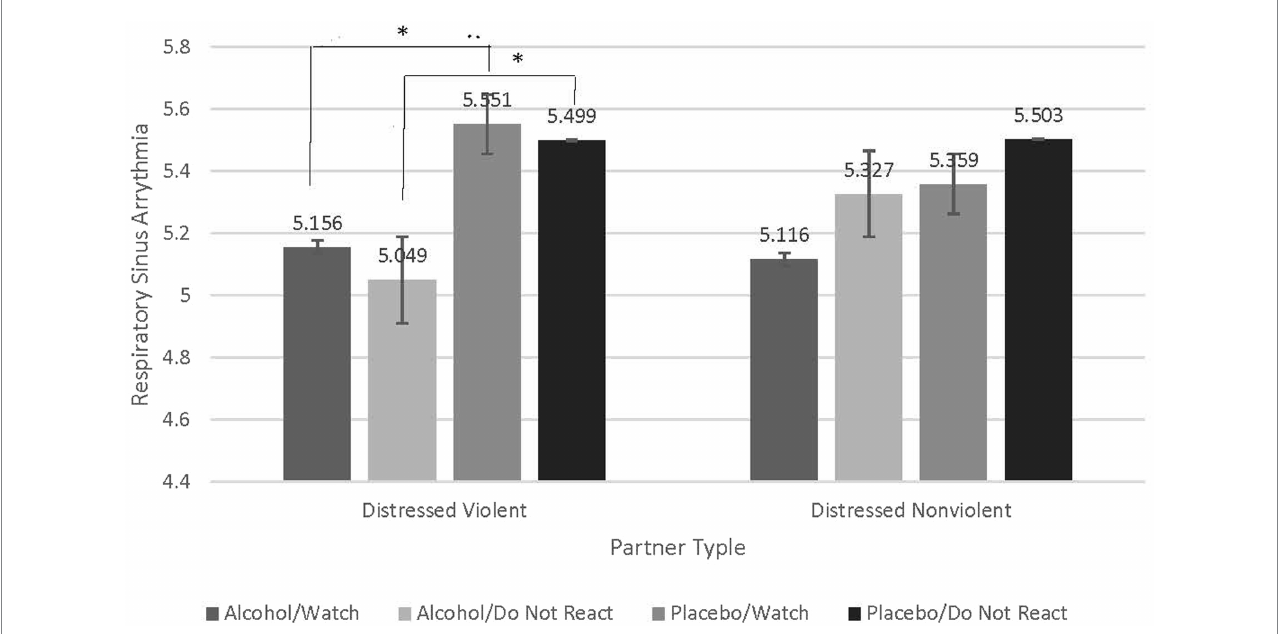
FIGURE 3 Contrasts examining significant interaction indicate greater decreases in respiratory sinus arrythmia in distressed violent partners compared to distressed nonviolent partners when intoxicated and attempting to not react to partner stimuli. Contrasts reveal that compared to distressed nonviolent partners, distressed violent partners, when intoxicated, exhibited significantly lower RSA when watching their partners’ stimuli (Watch; M difference = − 0.395, p = 0.030). Distressed violent partners also exhibited even lower RSA when intoxicated and trying not to react to their partners’ stimuli (Do Not React; M difference = −0 .450, p = 0.014). Distressed nonviolent partners did not exhibit significant differences in RSA in either emotion regulation condition under any beverage